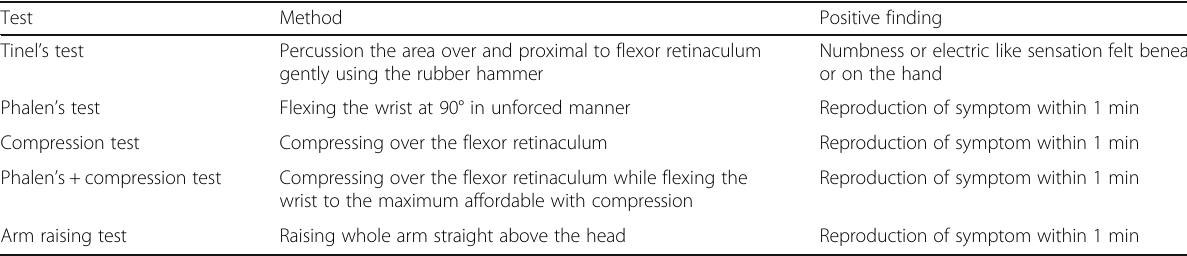
Table 1 Methods of performing tests and its positive finding Test